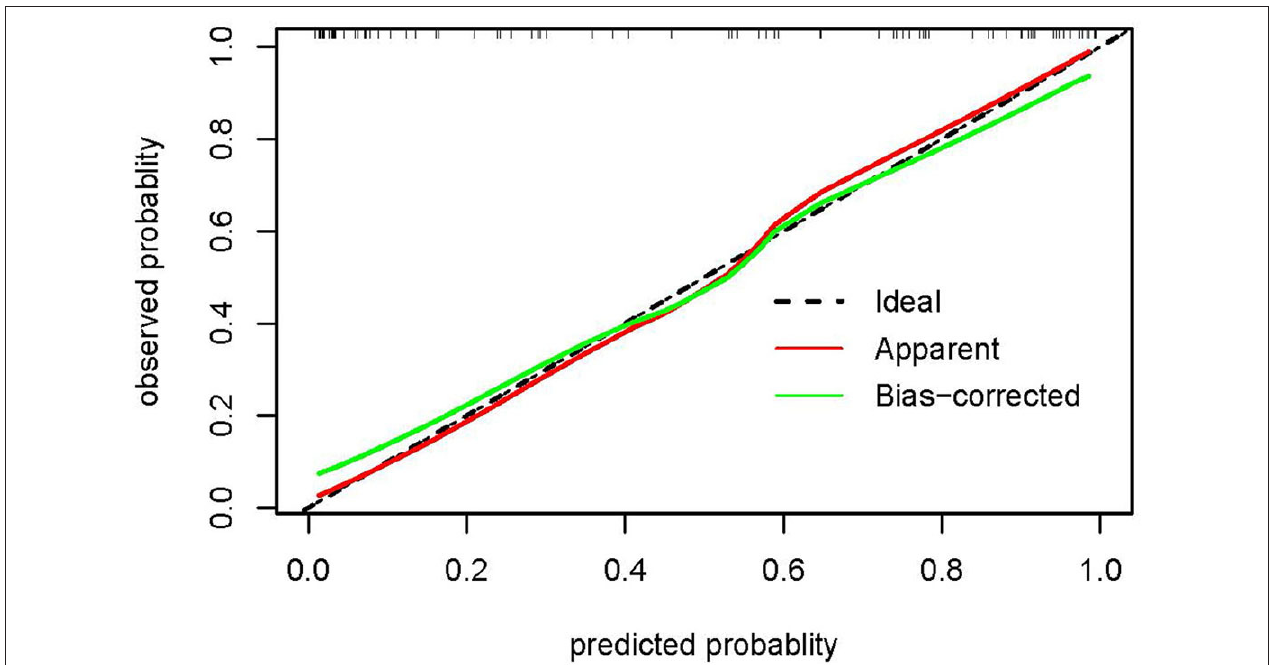
FIGURE 2 | The calibration plot of the nomogram in the modeling dataset. The x-axis shows the nomogram-predicted probability of unresolved risk, and the y-axis shows the actual observed probability of unresolved risk. The ideal line (45 ◦ ) in the calibration plots represents perfect consistency between the nomogram-predicted probabilities and the observed probabilities. The apparent line represents the model calibrated with the modeling dataset, and the bias-corrected line represents the model calibrated using the bootstrap method.